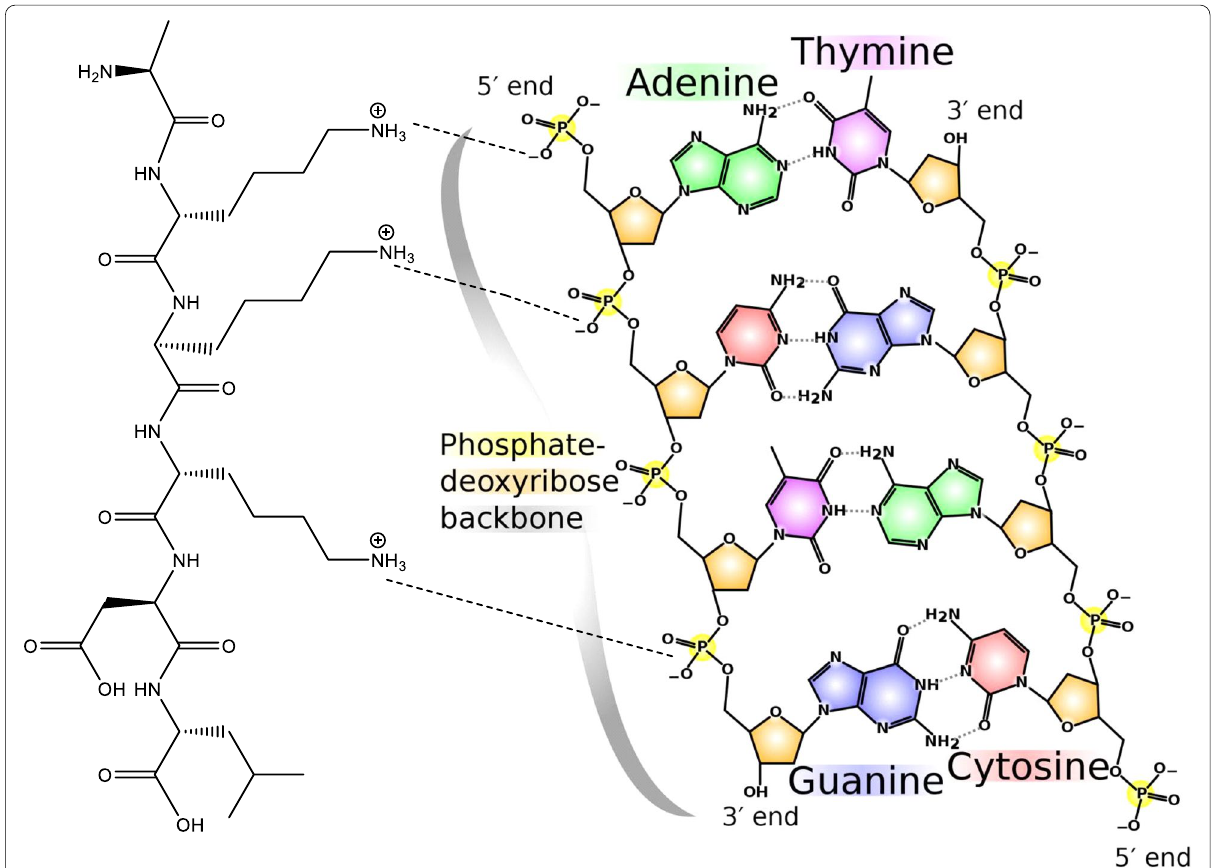
Fig. 3 Potential electrostatic interactions between basic proteins and nucleic acids (DNA and RNA)